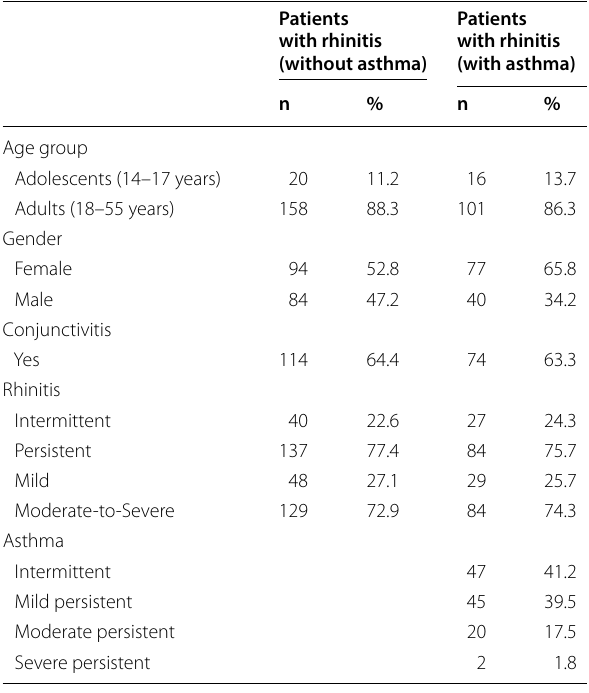
Table 1 Baseline characteristics